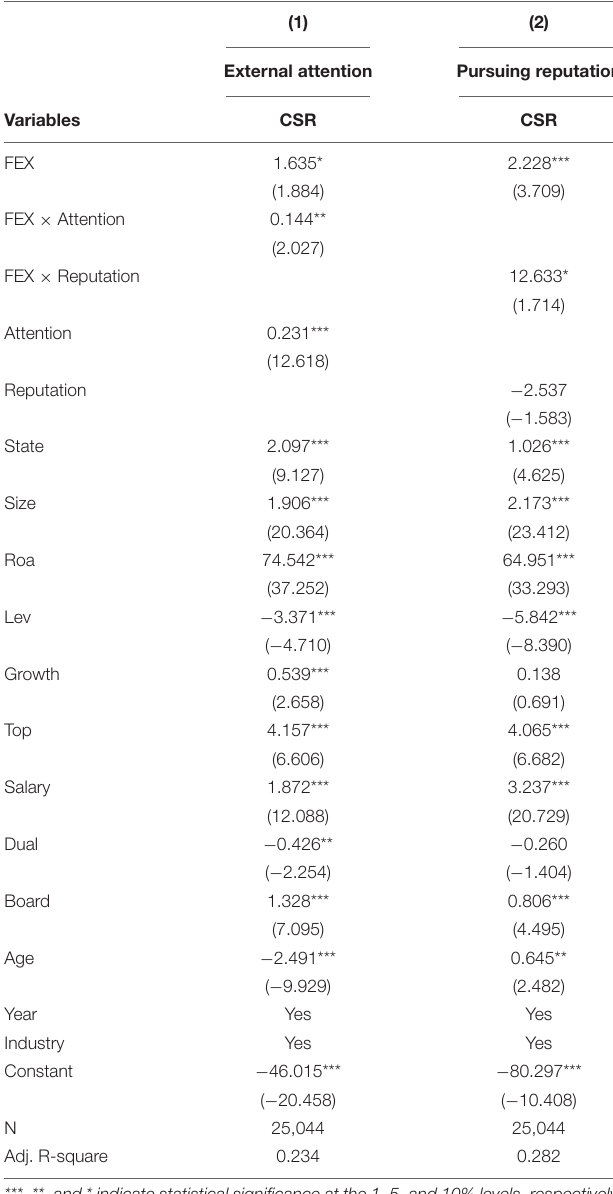
TABLE 4 | Motivation